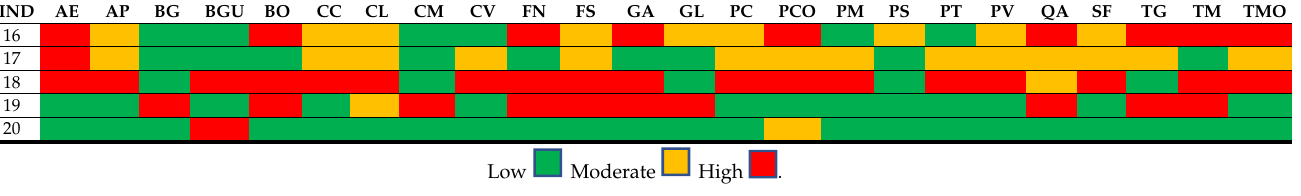
Table 6. Results obtained for the Infrastructure indicators of the different UFs.